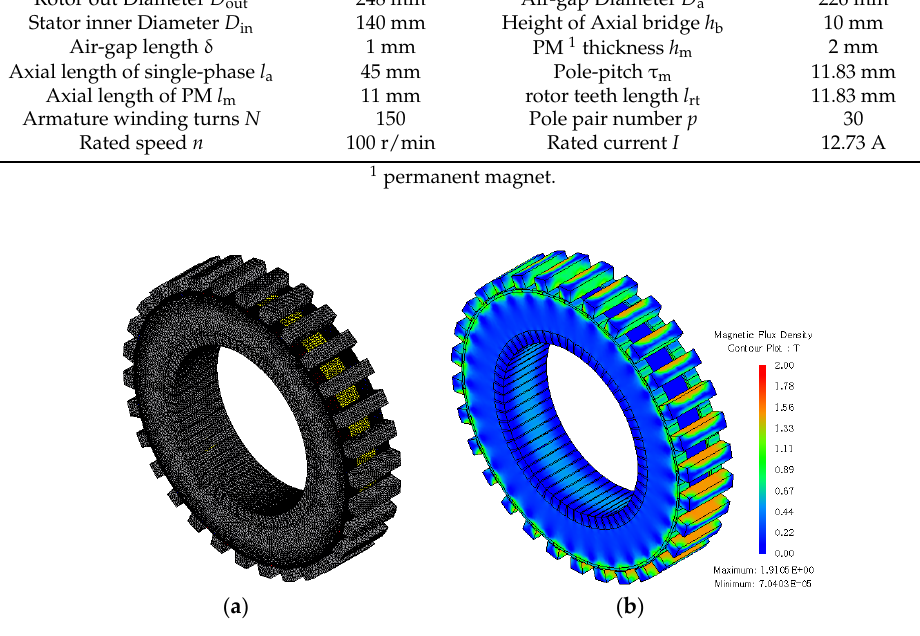
Figure 5. The three ‐ dimensional finite element model of single ‐ phase CS ‐ TFM: ( a ) mesh result; and ( b ) magnetic field distribution under rated current. ( b ) magnetic field distribution under rated current.